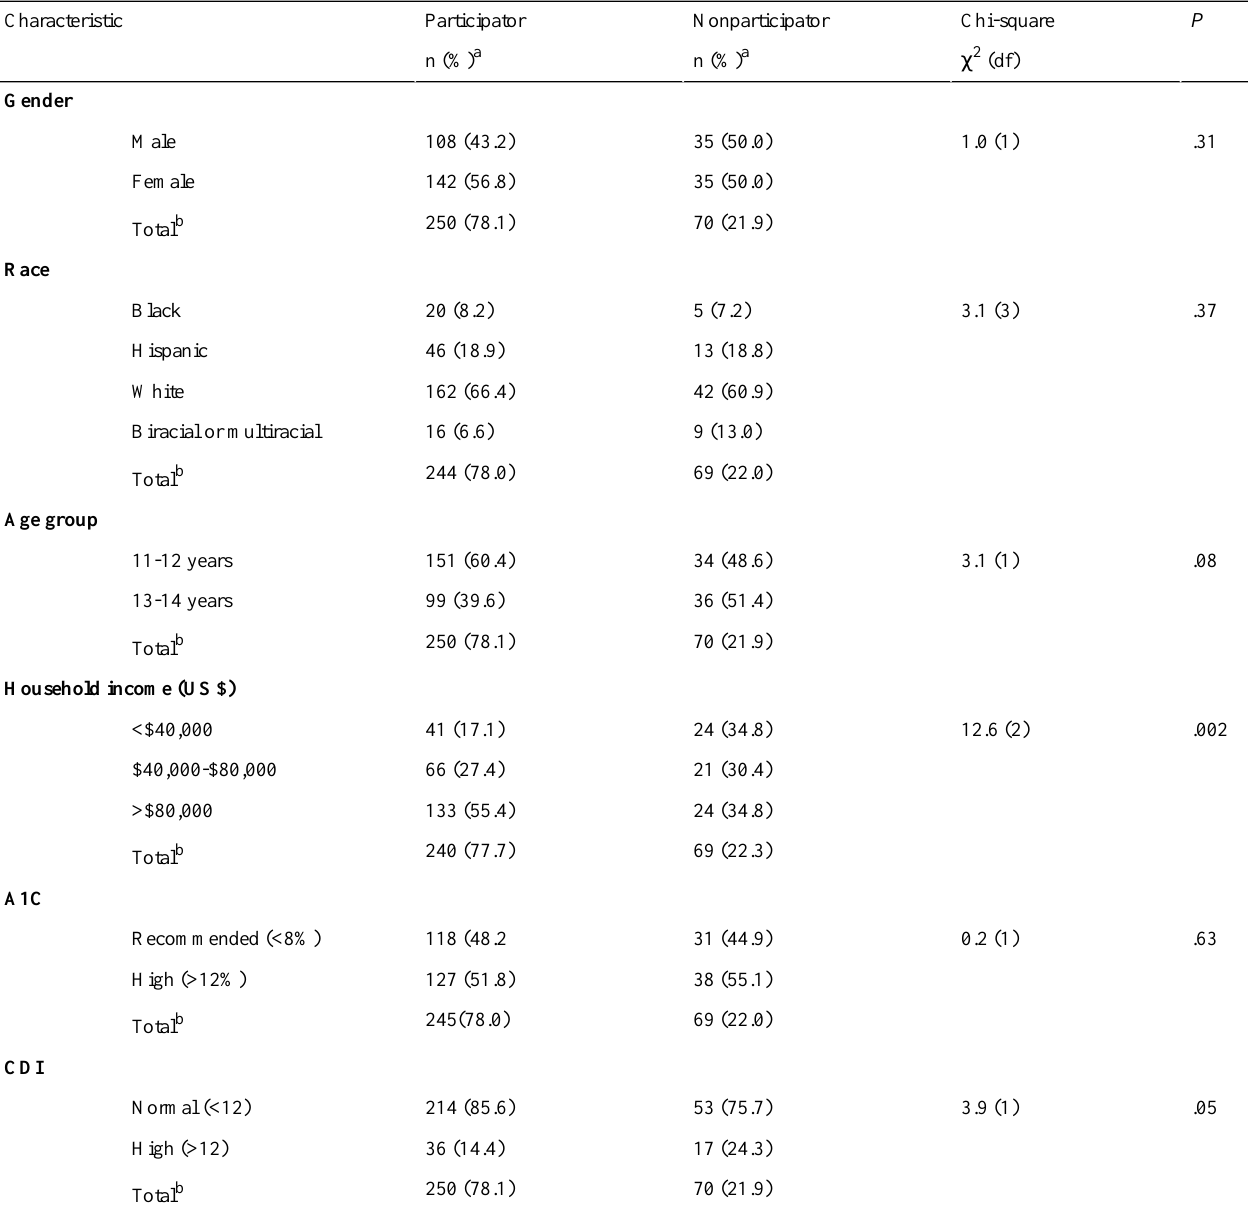
Table 3. Demographic differences in participation for participators (completed at least 4 sessions or 80%) and nonparticipators (completed <80% of